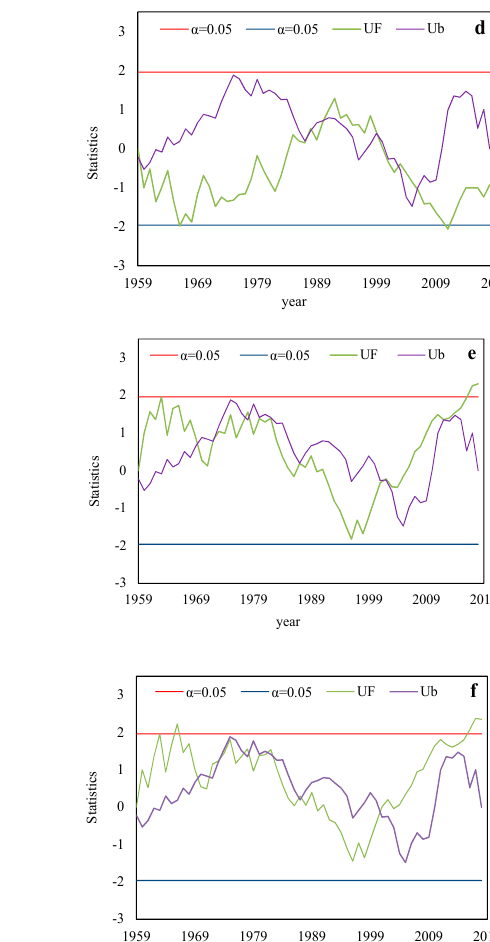
Figure 2. Spatial variation characteristics of effective precipitation ( P e ) during the entire growth period ( a ), early growth period ( b ), rapid growth period ( c ), middle growth period ( d ), and end growth period ( e ) of maize from 1959 to 2018.